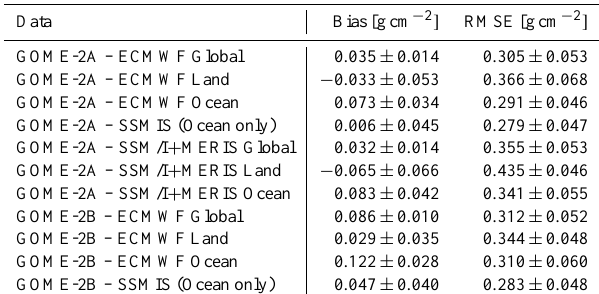
Table 2. Bias and RMSE statistics. The computations refer to the average difference GOME-2 data. The time period analysed is January 2007–April 2014 for the comparison GOME-2A – ECMWF ERA-Interim, January 2007–June 2014 for GOME-2A – SSMIS and January 2007–December 2008 for GOME-2A – SSM/I + MERIS. We use GOME-2B data starting from January